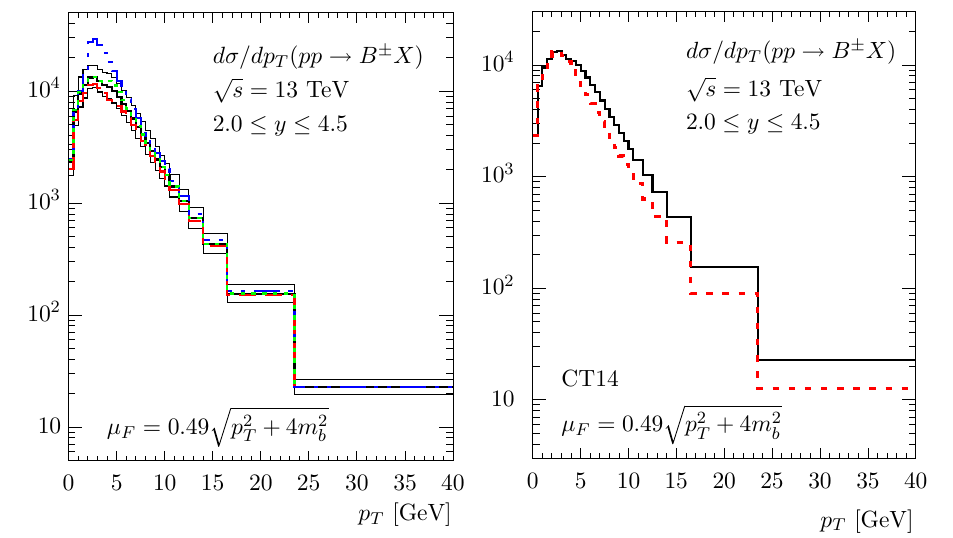
√ = 4 . 5 GeV; red (long-dashed) histogram: NNPDF3.1 with m ( thr ) S = 13 TeV inte- (cid:2) b = 4 . 92 GeV. We also show the theory uncertainty band for CT14 + 4 m 2 m ( thr ) p 2 , b T b (thinblacklinehistogram).Right:Theblack(fullline)histogramshows = b the complete result for the CT14 PDFs, the red (dashed-line) histogram ( thr ) = shows the result without contributions due to b quarks in the initial state b